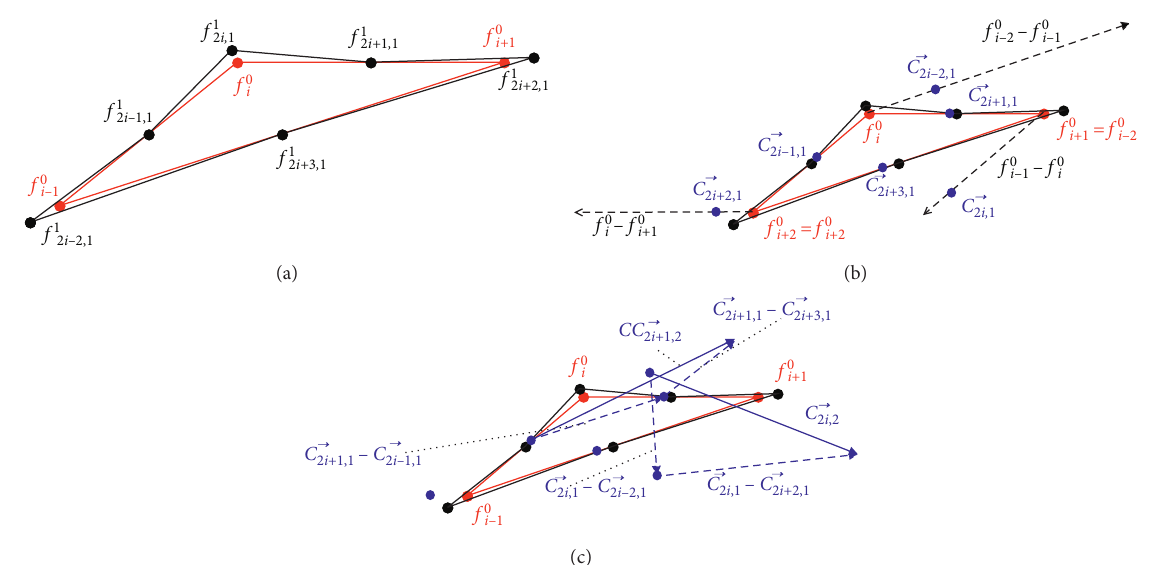
Figure 2: Geometrical interpretation of the proposed framework. Red bullets and red lines represent initial points and initial polygons, respectively. Black bullets and black lines represent the points and the polygons obtained by the subdivision scheme (17).